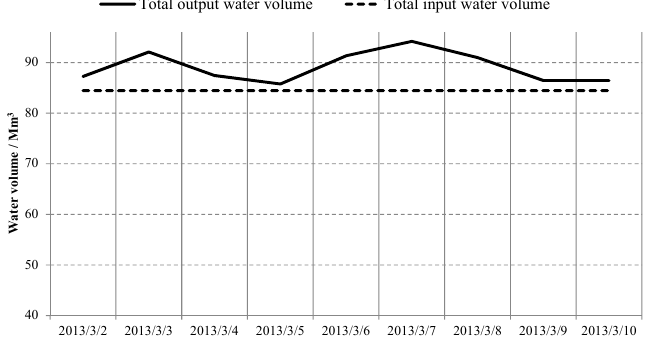
Figure 12. The water volume process of the Tieshi reservoir during the operation period. (2) Operation process of the key waterworks during the operation period.